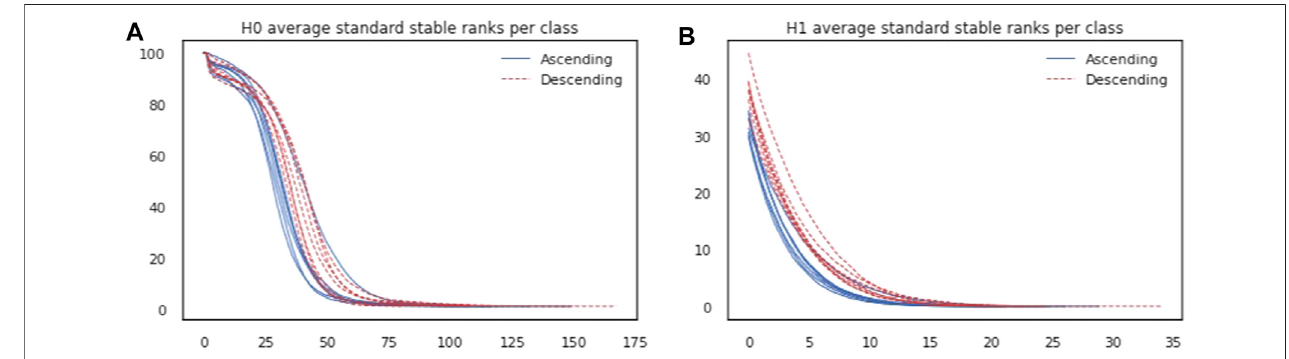
FIGURE 10 | (A) : 0-th homology average standard stable ranks per class. (B) : 1-st average standard stable ranks per class.